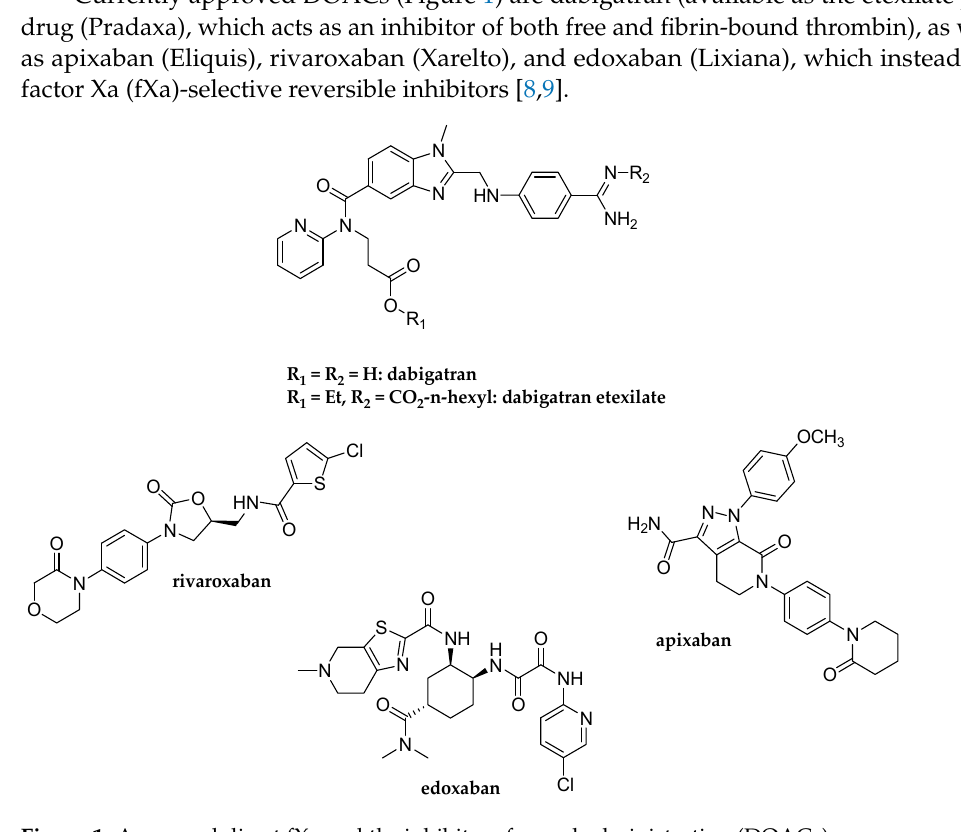
Figure 1. Approved direct fXa and thr inhibitors for oral administration